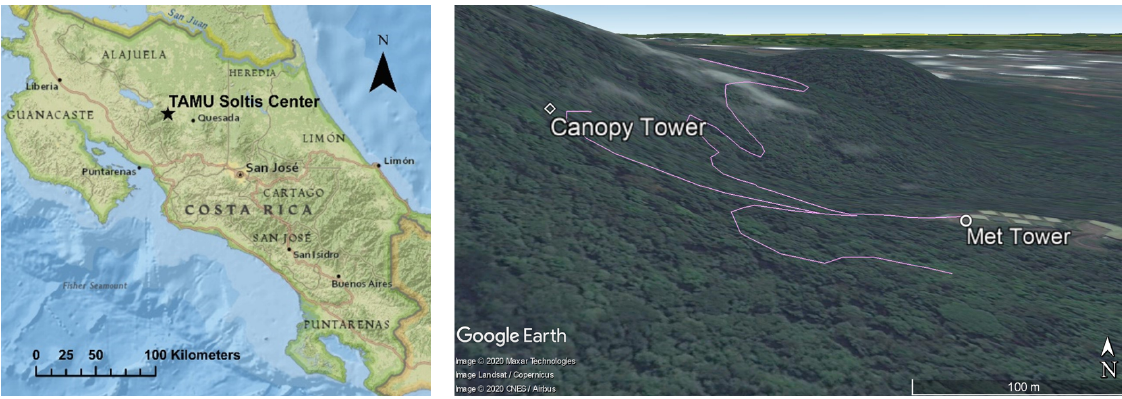
Figure 1. The map of the study site and the locations of the two towers (Andrews,